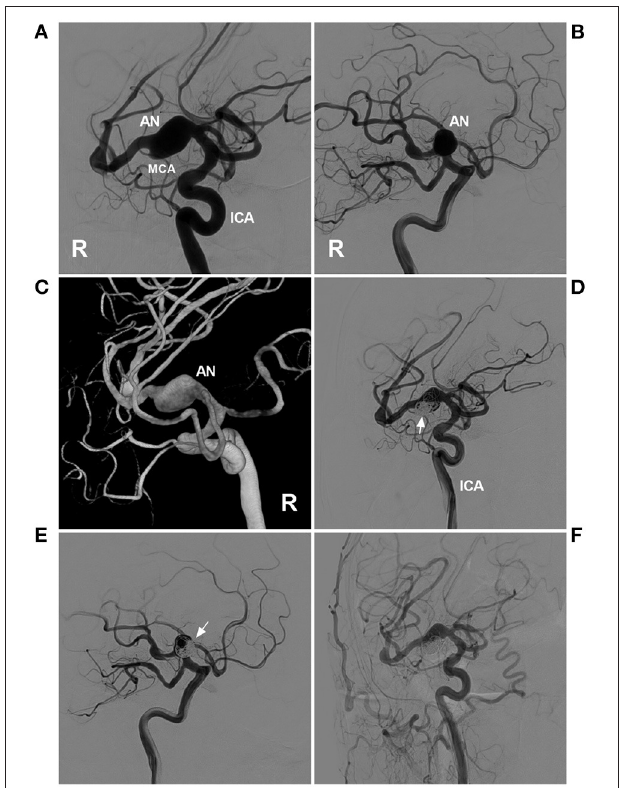
FIGURE 9 | Targeted coiling for a fusiform AN of the MCA trunk. (A,B) DSA of the right ICA showed a fusiform AN. (A,B) show different projection degrees. (C) Three-dimensional DSA of the ICA revealed the fusiform AN more clearly. (D,E) DSA of the ICA showed that the AN was coiled by targeting the lower part of the aneurysm under stent assistance (arrows). (D,E) show the different projecting degrees. (F) Follow-up DSA of the common carotid artery indicating satisfactory coiling. AN, aneurysm; DSA, digital subtraction angiography; ICA, internal carotid artery; MCA, middle cerebral artery; R, right.